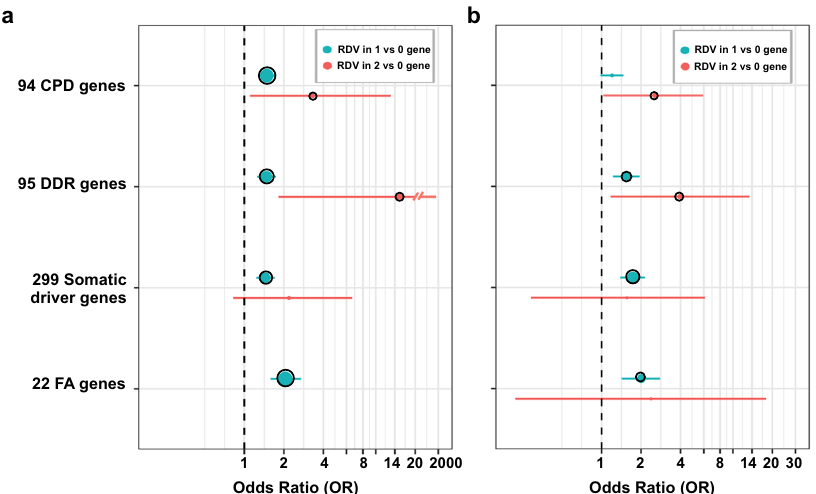
Fig. 4 Cancer risk based on RDV load. a Discovery cohort; b Validation cohort. The whiskers span the 95% con fi dence interval for OR values (penalized logistic regression). The black circle outline indicates signi fi cant burden p ≤